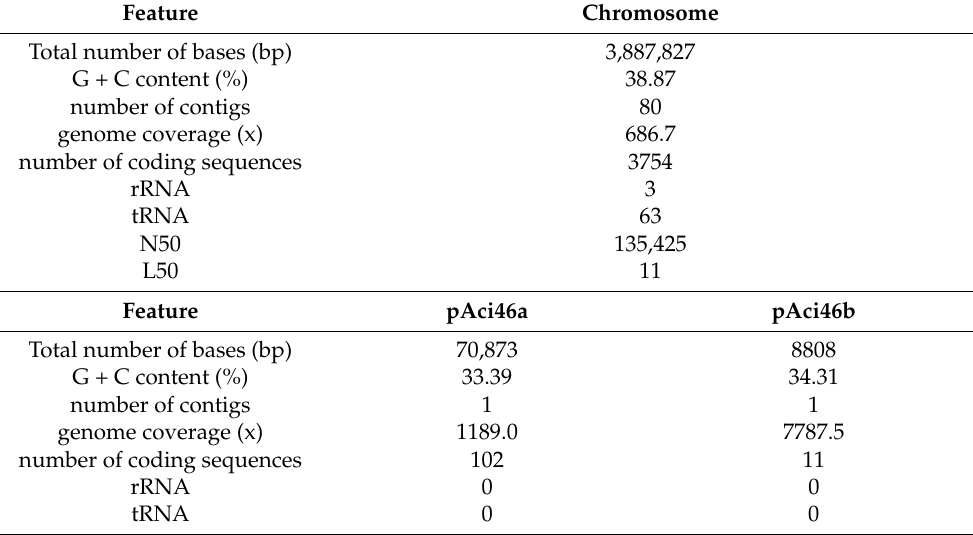
Table 2. Standard data of Aci46 genome